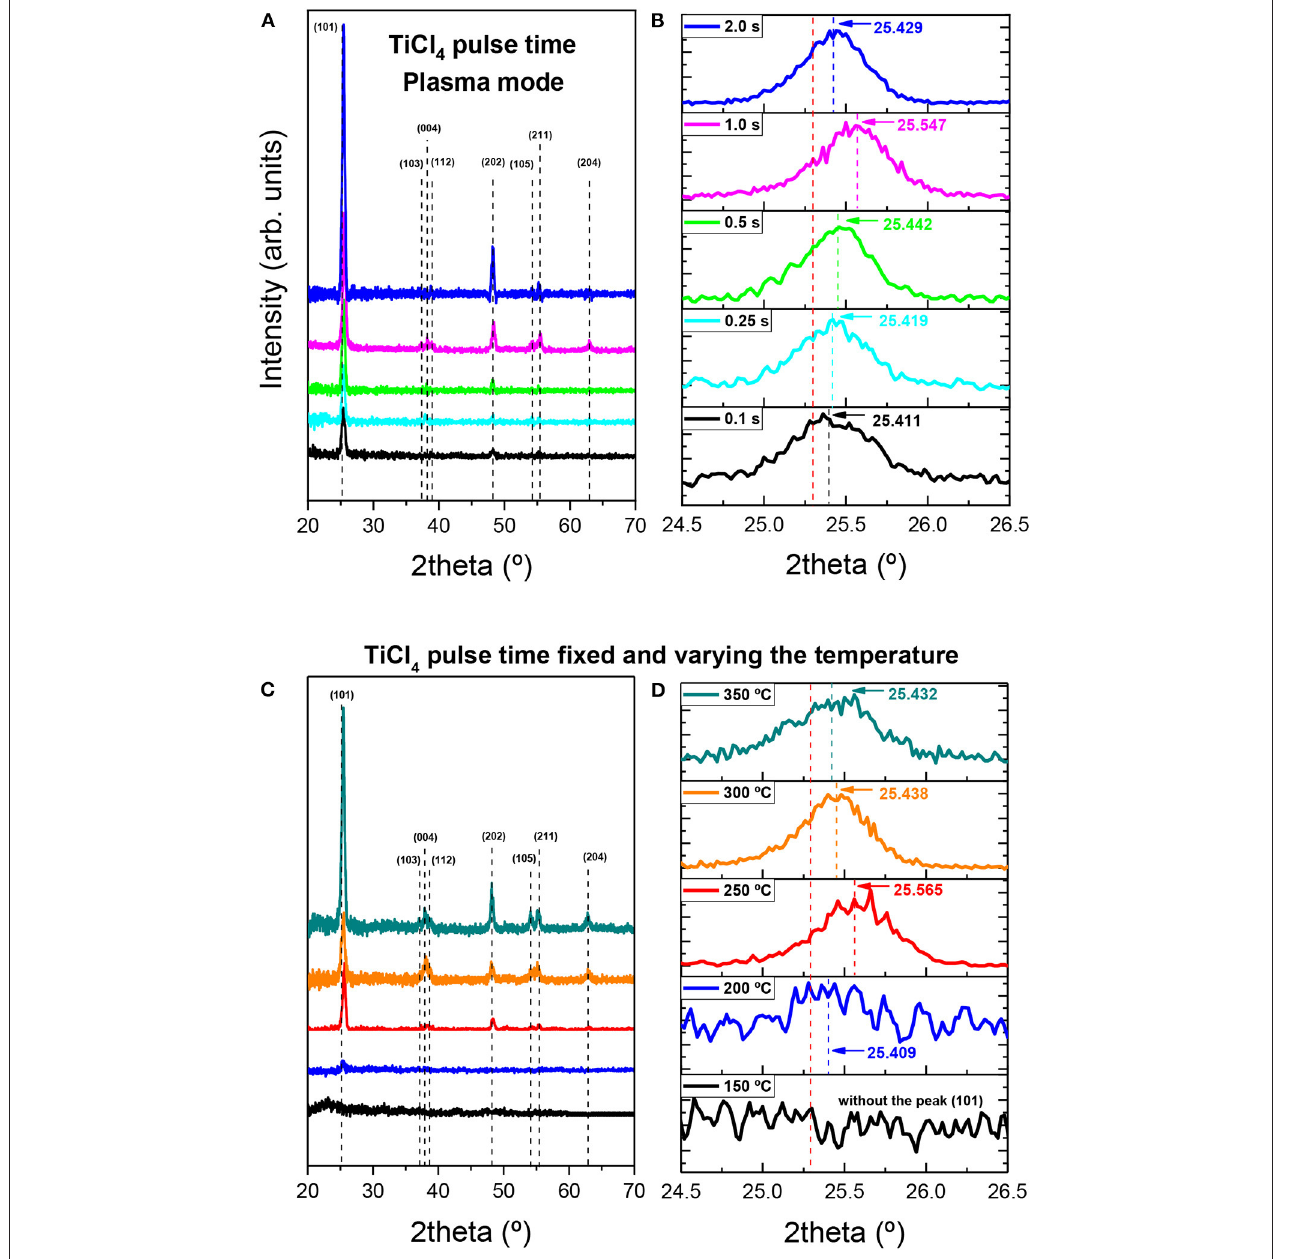
FIGURE 9 | GIXRD diffractogram for TiO 2 film growth using TiCl 4 precursor: (A) fifth set of samples, (B) peak (101) for the fifth set of samples, (C) eighth set of samples, and (D) peak (101) for the eighth set of samples.